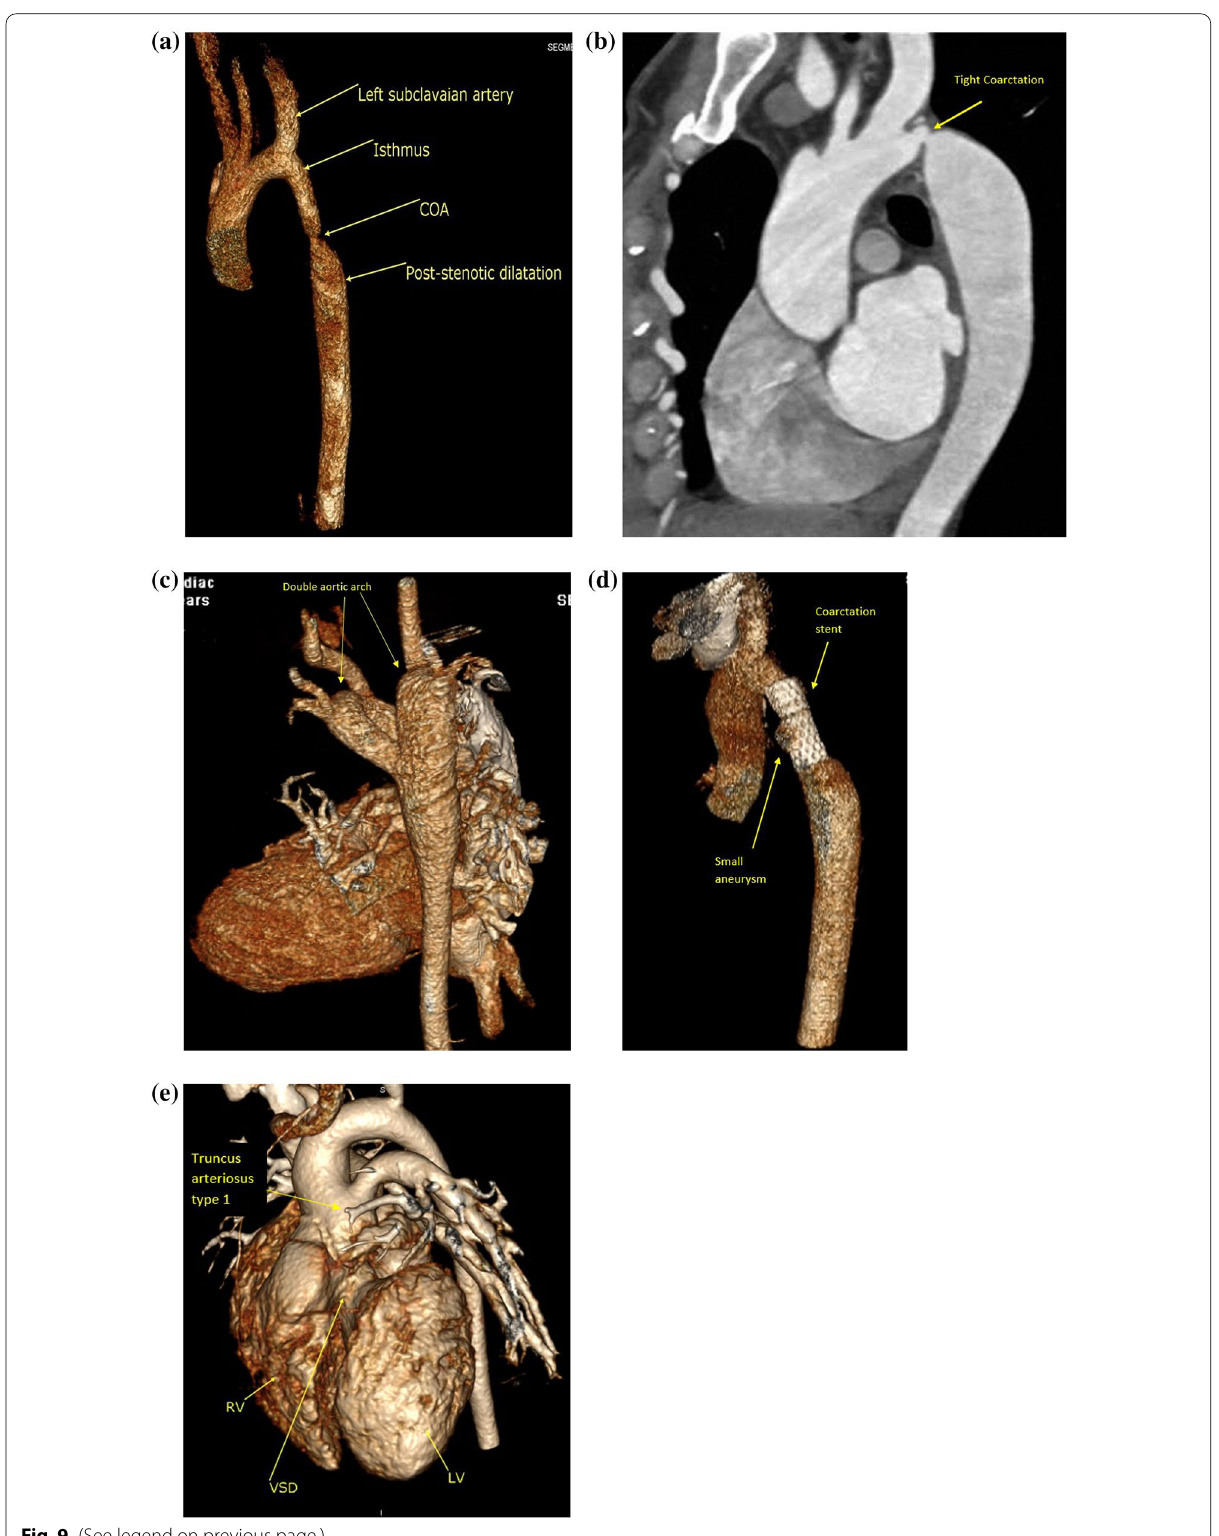
Fig. 9 (See legend on previous